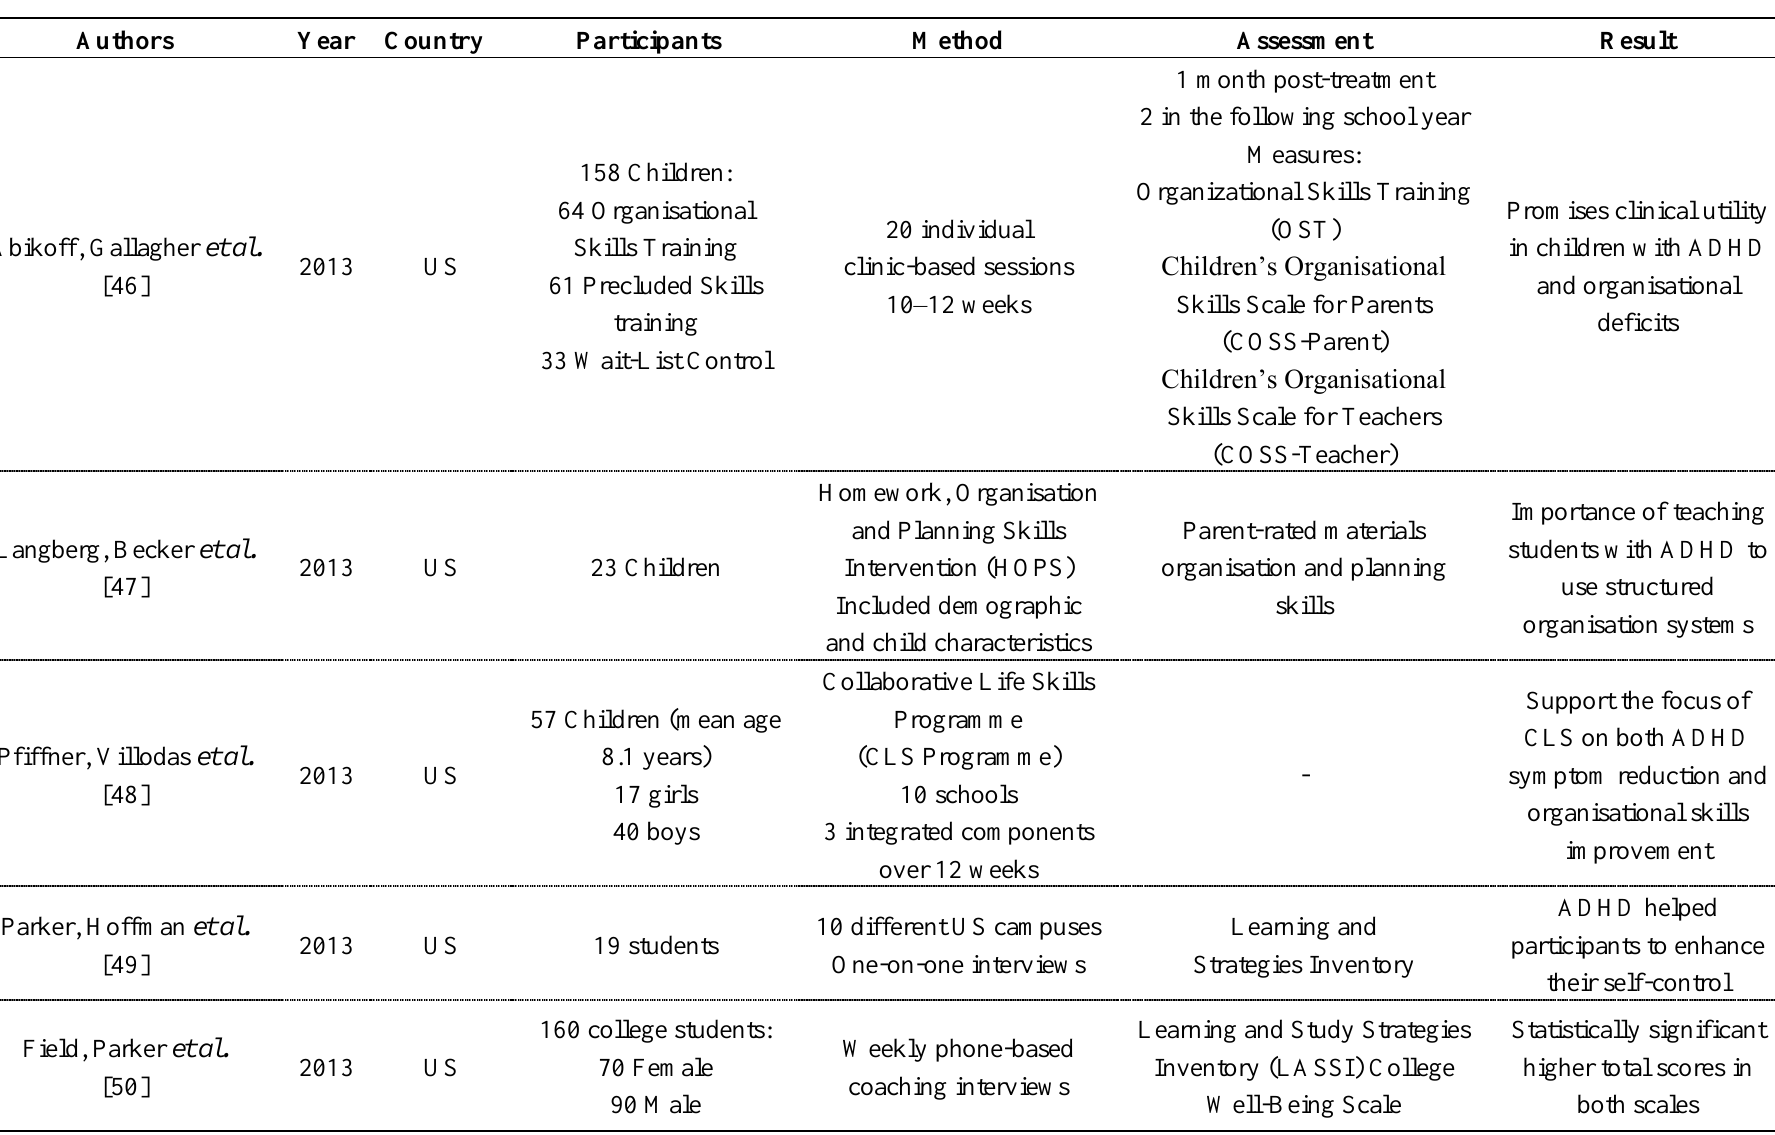
Table 2. Review of Time Management and